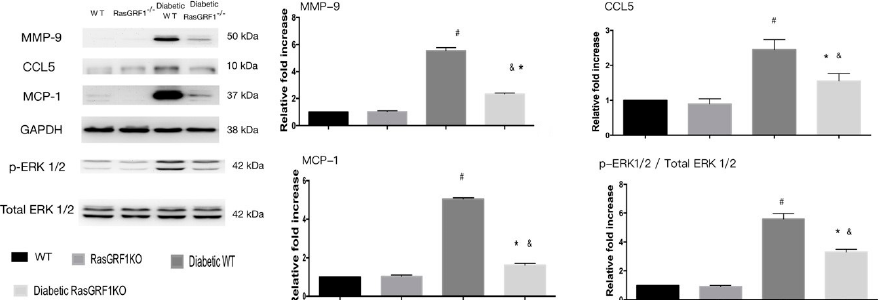
Figure 8. Effects of Rasgrf1 knockout prevented diabetes-induced inflammation processes through the ERK pathway. Chronic diabetes status upregulated the proteins of inflammatory cytokines and chemokines makers: including monocyte chemoattractant protein-1 (MCP-1), chemokine (C–C motif) ligand 5 (CCL5), and MMP-9: ( n = 3). These upregulation proteins were prevented in RasGRF1 − / − mice. The protein levels are expressed as a ratio to β -actin, and normalized to sham control wild-type (WT). In additional, the chronic diabetic status induced the phosphorylation of ERK1/2. The diabetic RasGRF1-attenuated diabetic status induced the phosphorylation of ERK1/2. The protein levels are expressed as a ratio to total ERK1/2 and normalized to sham control wild-type (WT). Data are shown as mean ± SEM in three independent experiments. # p < 0.01 vs. normal WT and normal RasGRF1 − / − mice; * p < 0.05 vs. diabetic WT mice. & p < 0.05 vs. normal WT and normal RasGRF1 − / − mice. WT: wild